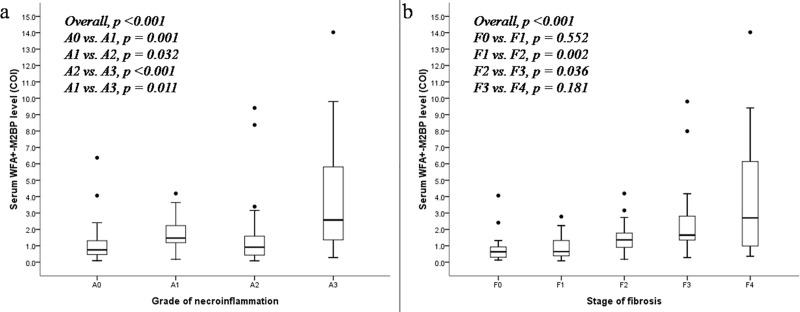
The correlations between serum WFA+-M2BP leveland necroinflammation grade (a) and fibrosis stage (b).